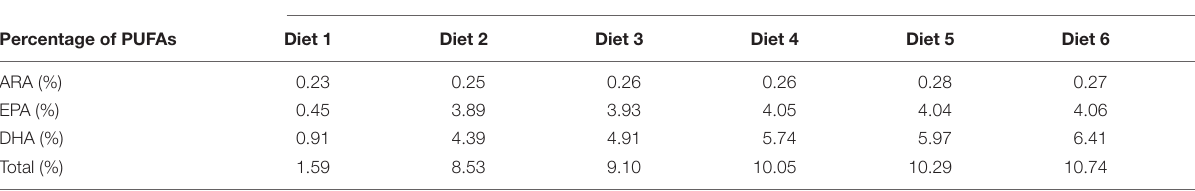
TABLE 2 | Main polyunsaturated fatty acid content of feed.